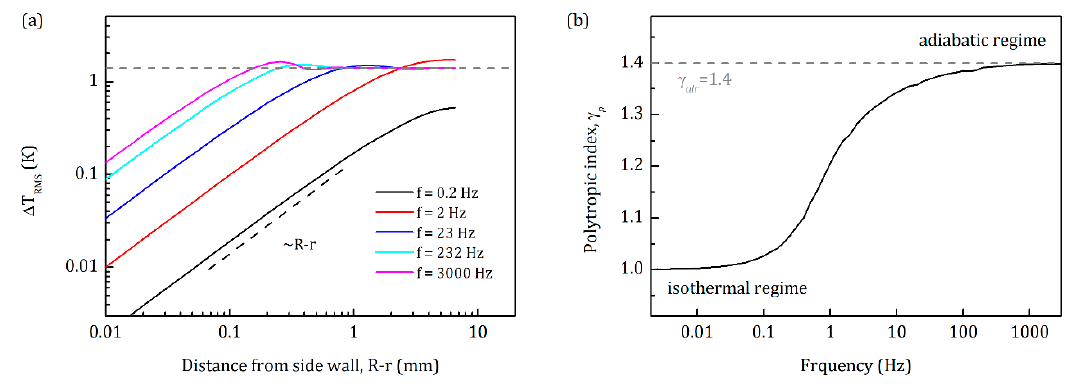
Figure A2. ( a ) Root mean square change in temperature at the middle of the chamber ( z = L / 2) depending on the distance from the side wall of the sensor at di ff erent frequencies. The horizontal gray dashed line shows the estimated value during the adiabatic process inside the chamber. ( b ) Calculated polytropic index γ P showing the transition from isothermal regime to adiabatic regime for the sensors used in this work. Gray dashed line reflects the adiabatic index for air, γ air = 1.4.